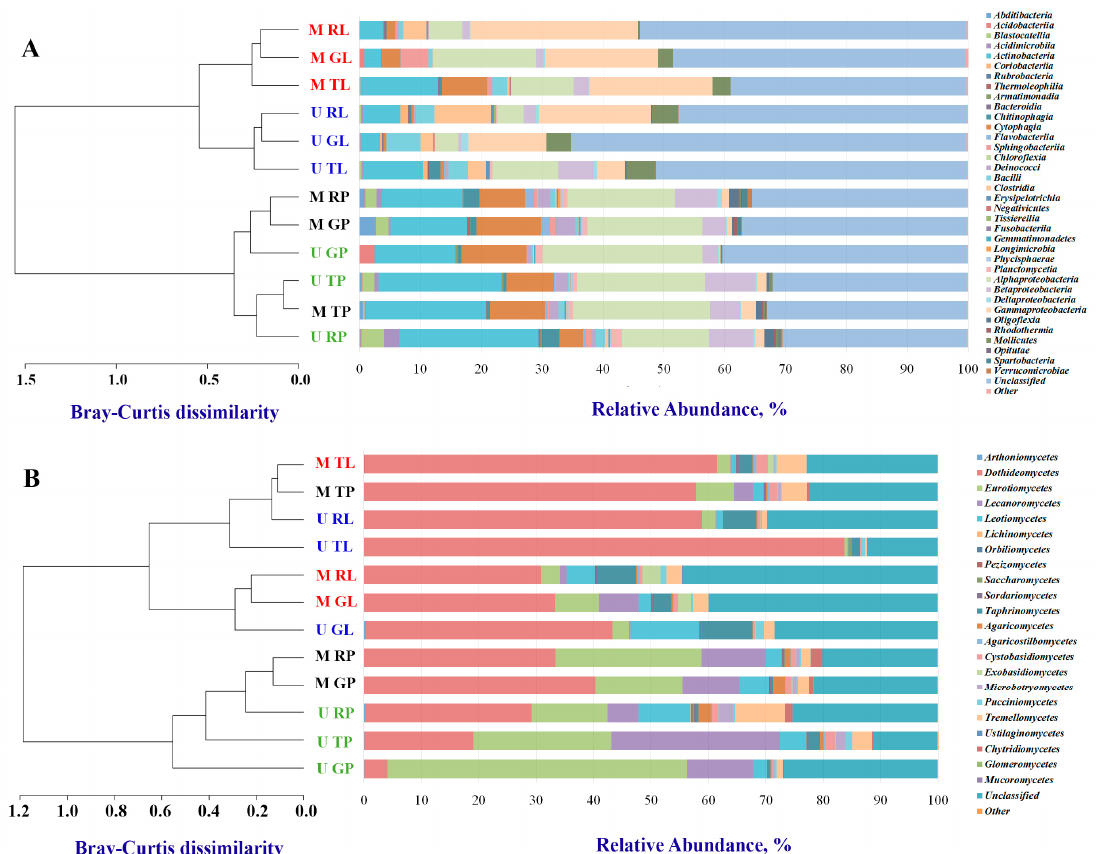
Figure 2. Distribution of the most abundant bacterial ( A ) and fungal ( B ) classes (read frequency > 0.1%) identified in functional zones and biotopes of Moscow and Murmansk. Unclassified phyla and phyla with relative abundance ≤ 0.1% were considered as “Unclassified” and “Other”, respectively.